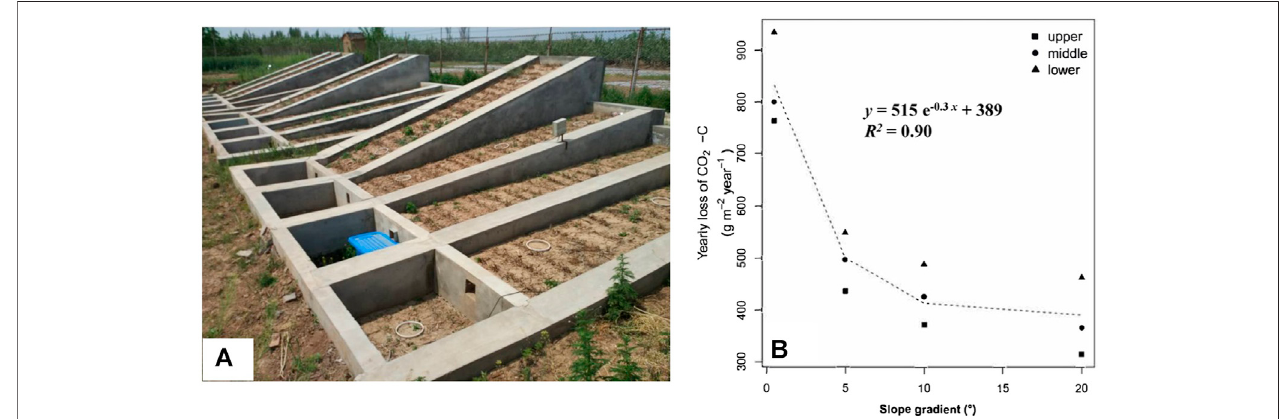
FIGURE 3 | Slope-dependent CO 2 emission model (A) developed from erosion plots (B) nearby the Wangdong Catchment, Chinese Loess Plateau. More descriptions on the slope-dependent CO 2 emission model, please refer to Hu et al. (2020b); to learn more about the setting up of erosion plots, please refer to Du et